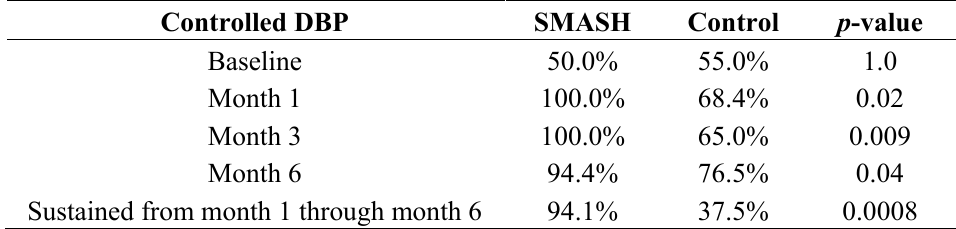
Table 3. Proportion of participants by Group with DBP